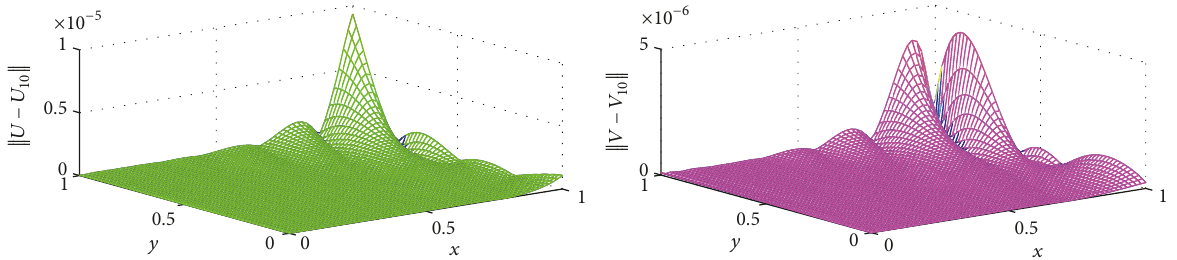
Figure 2: Absolute error in 𝑈(𝑥, 𝑦) and 𝑉(𝑥, 𝑦) using 𝐾 = 10 of Problem